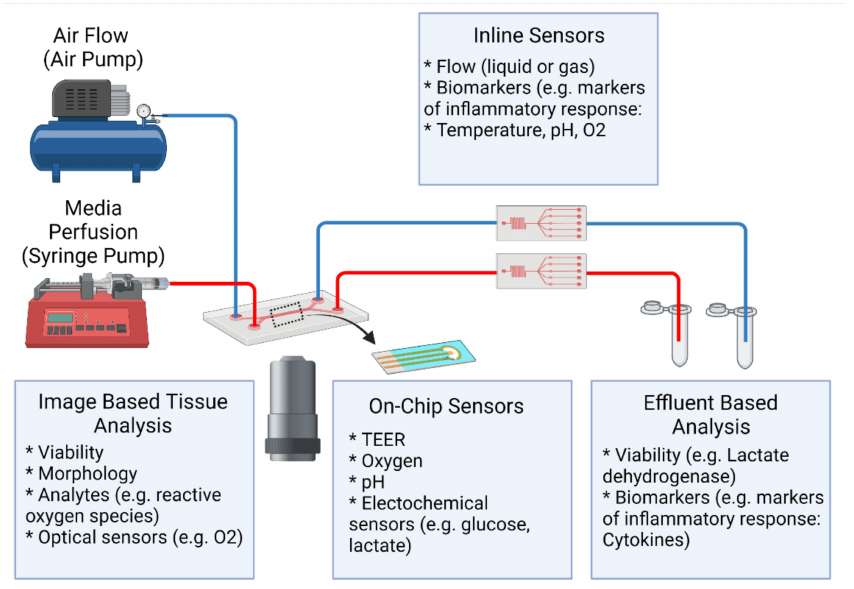
Figure 6. Readouts from Lung-On-A-Chip Devices. Lung-on-a-chip technologies allow time-varying, dynamic inputs to the microtissues, such as flow (both media flows to mimic blood flows as well as gas flows to mimic inhalation) or biochemical stimulation. These platforms can be integrated with technologies to monitor the outputs. Continuous measurements can give information about evolution of the biological response, while snapshot endpoint measurements can also be adapted to the microscale platforms. On-chip sensors (e.g., optical, electrical, electrochemical) are integrated within the organ-on-chip device itself. In-line sensors are external sensors that can be used to monitor the input and/or outputs to the